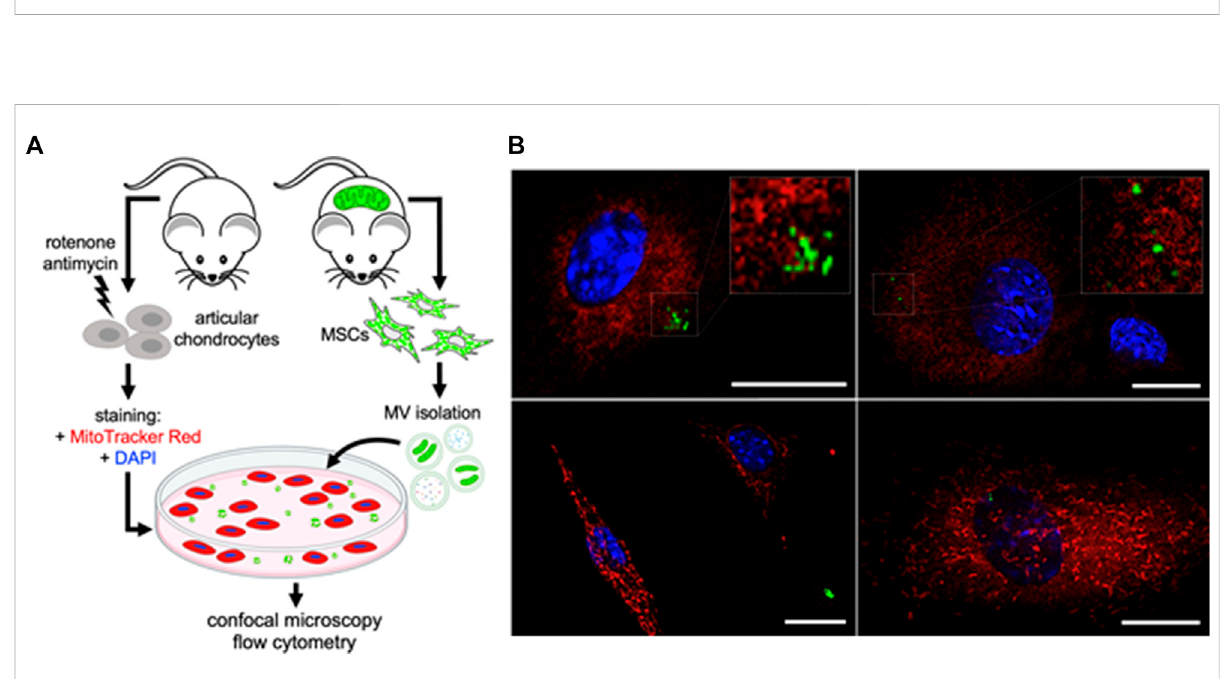
FIGURE 4 Murine Chondrocytes take up MT from MSC-derived Microvesicles (A) Schematic depicting experimental method for imaging non-contact intercellular MT transfer (B) Confocal images of MSC-MitoEVs and mitoEV mediated MT transfer. MT Transfer demonstrated with mitoEVs (green) incorporated into chondrocyte MT networks (red). Chondrocytes were co-cultured with MSC-microvesicles for 12 h, then fi xed and imaged.